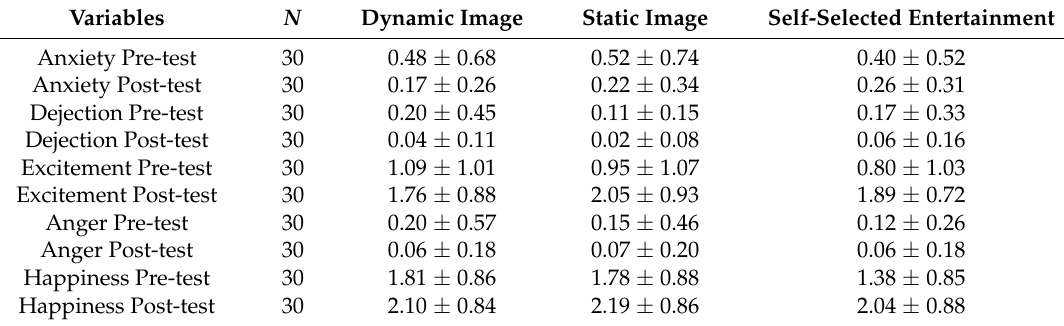
Table 2. The pre-and -post run scores of five subscales of Sport Emotion Questionnaires (SEQ) of three Table 2. The pre ‐ and ‐ post run scores of five subscales of Sport Emotion Questionnaires (SEQ) of different conditions (mean ± three different conditions (mean ± SD).